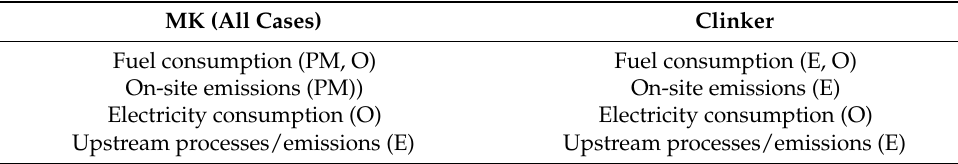
Table 2. Origin of data used in LCA calculations (PM—process model results; E—existing Ecoinvent inventories; and O—custom-made inventories from other literature